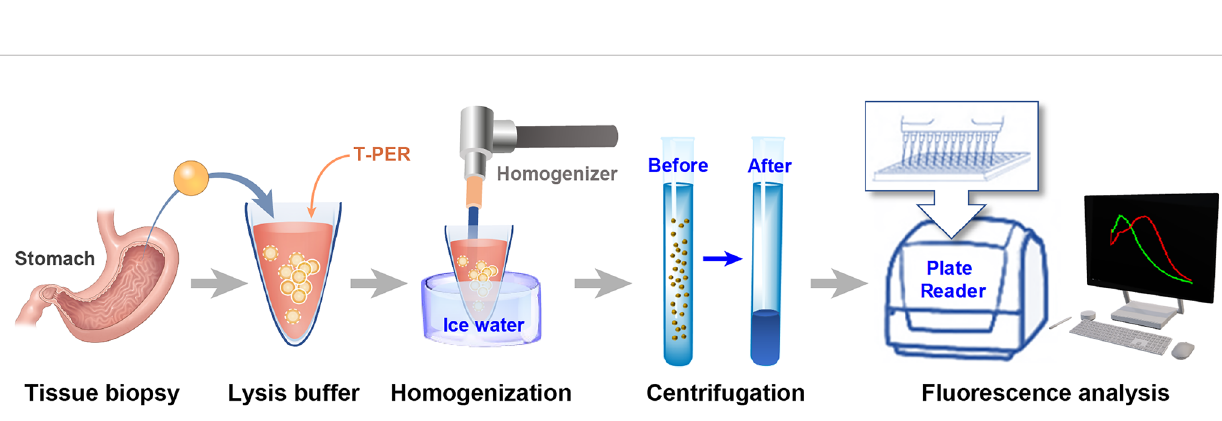
FIGURE 5 | Two-photon microscopy sectional ratiometric image of the area indicated by the red box and 3-dimensional ratiometric two-photon microscopy image of stomach tissue with SE1 (Schematic illustration).